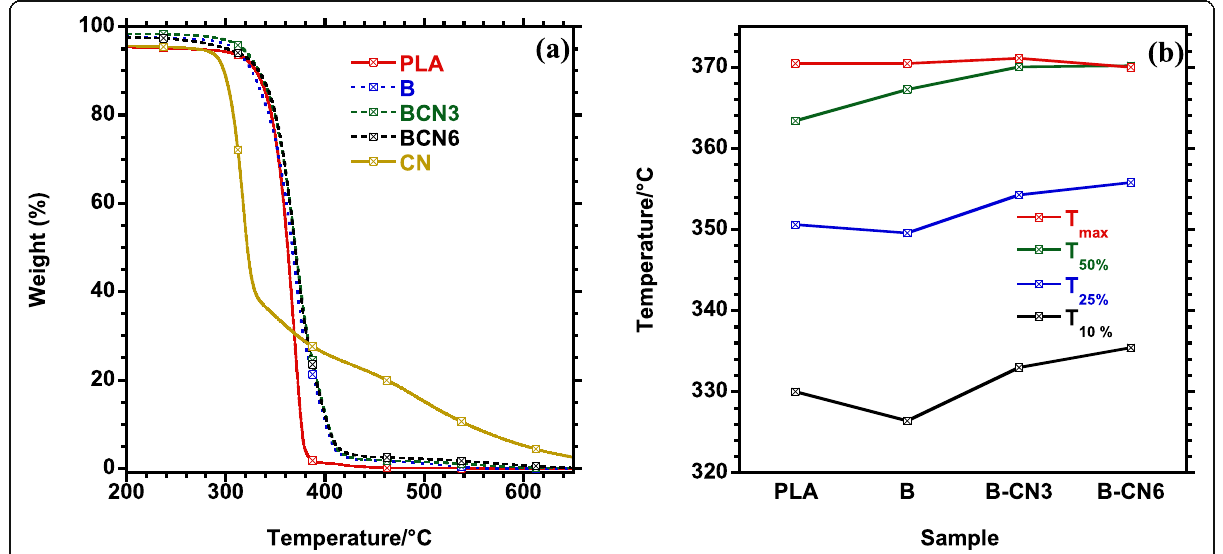
Fig. 5 a Thermal degradation curve of the prepared foams and CN and b trend showing temperatures at different weight